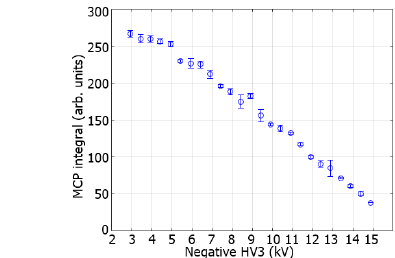
Figure 3: First results of p beam time with ELENA in AEgIS. Left: p capture and annihilation on rest gas, monitored via two sets of external scintillators. Right: Amount of p passing the barrier of an HV electrode after energy degradation, as observed on a downstream